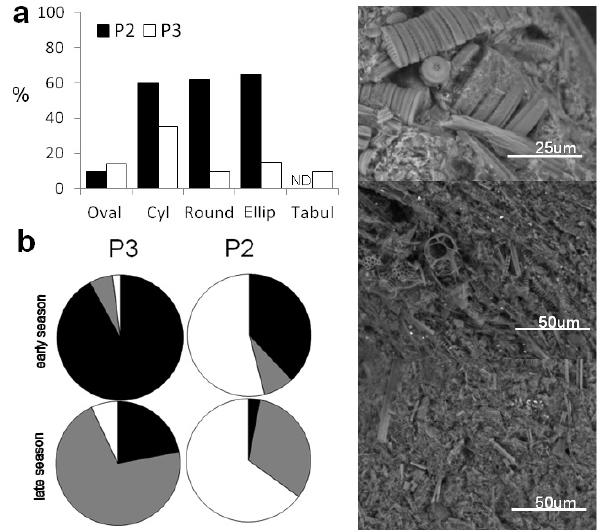
Figure 5. Left: (a) percentage of FP with evidence of degradation (i.e fragmented and/or with the peritrophic membrane partially bro- ken) at P3 and P2; (b) percentage of FP within sediment trap sam- ples from early season (upper) and late season (lower) at P3 and P2, presenting mainly a content of intact diatoms (grey), fragmented di- atoms (black) and reworked material (white). Right: scanning elec- tron micrographs showing the diversity of FPs within sediment trap